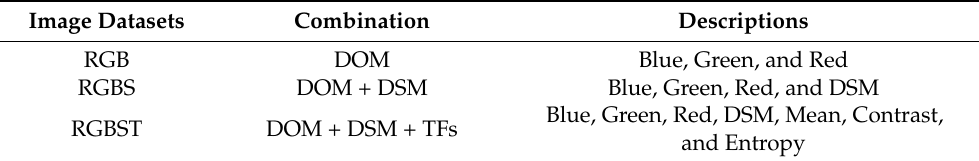
Table 1. Different image